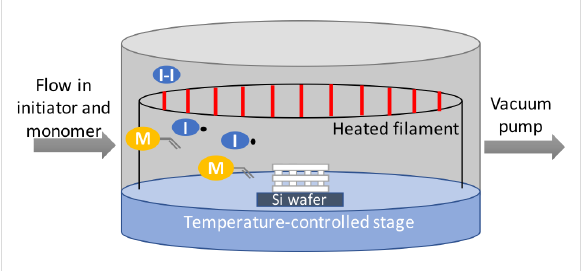
Figure 1: Schematic of the iCVD process. The 3D-printed substrate (white lattice) is placed on a silicon wafer piece on a temperature-con- trolled stage. Initiator (I–I) and monomer (M) in vapor phase are intro- duced into the reactor and the filament array is heated to thermally cleave the